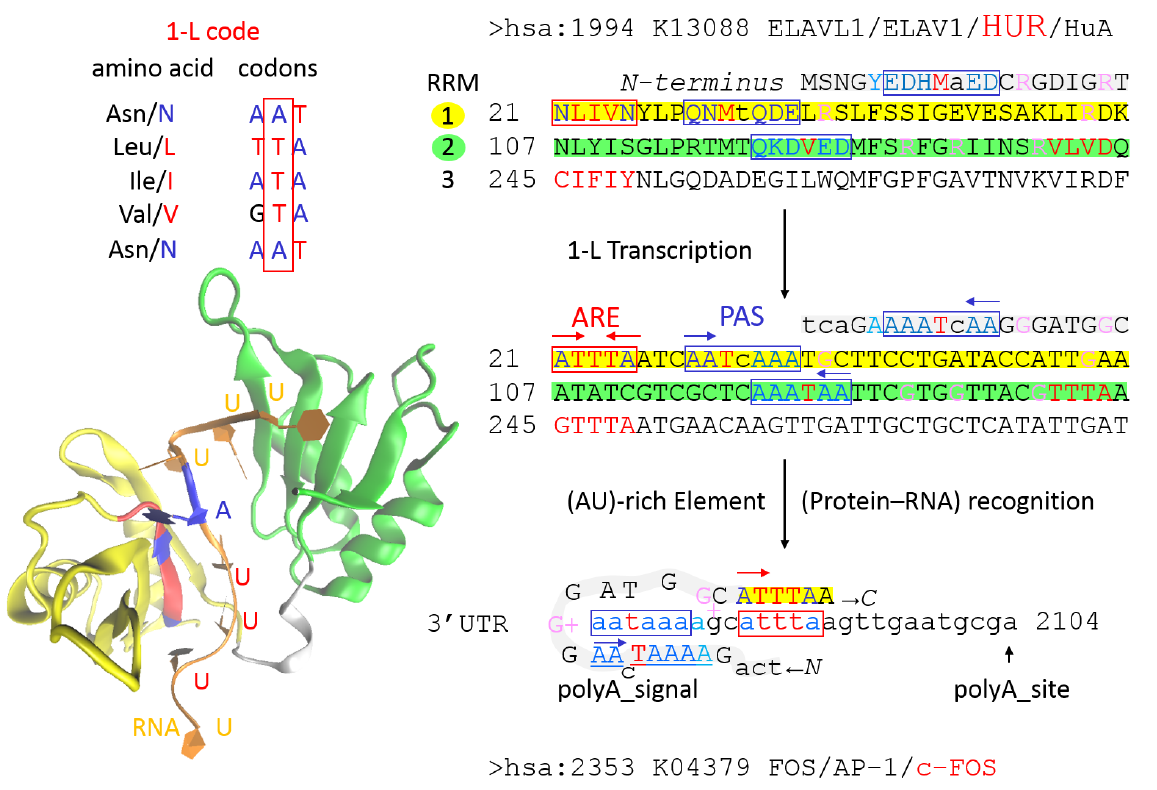
Figure 2. 1-L code and 1-L RBP HUR transcription. HUR is a key regulator of cellular mRNAs containing adenylate/uridylate-rich (ARE) elements, for example, it regulates the stability of FOS mRNA. It has three RNA recognition motifs (RRM), the first is the most conserved and can be accurately transcribed into ARE and PAS sequences by 1-L transcription. The structure of RRM1-RRM2 (4ed5) shows that the sequence 21NLIVN is involved in ARE recognition, but the uncrystallized disordered N-terminus may also be involved in recognition, based on the obtained 1-L compatibility between the HUR N-terminus and the c-FOS 3 ′ UTR.